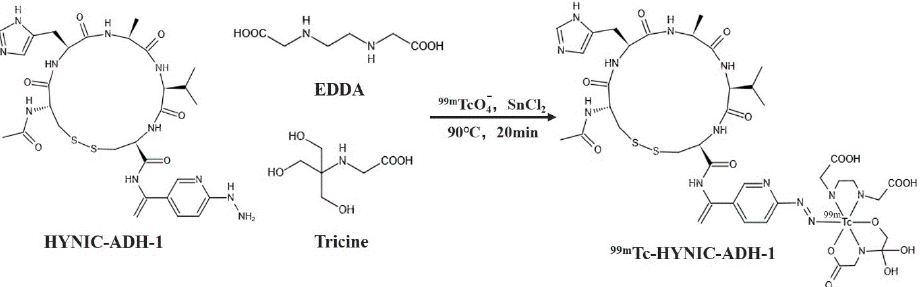
Figure 1. Labeling reaction of 99m Tc-HYNIC-ADH-1.